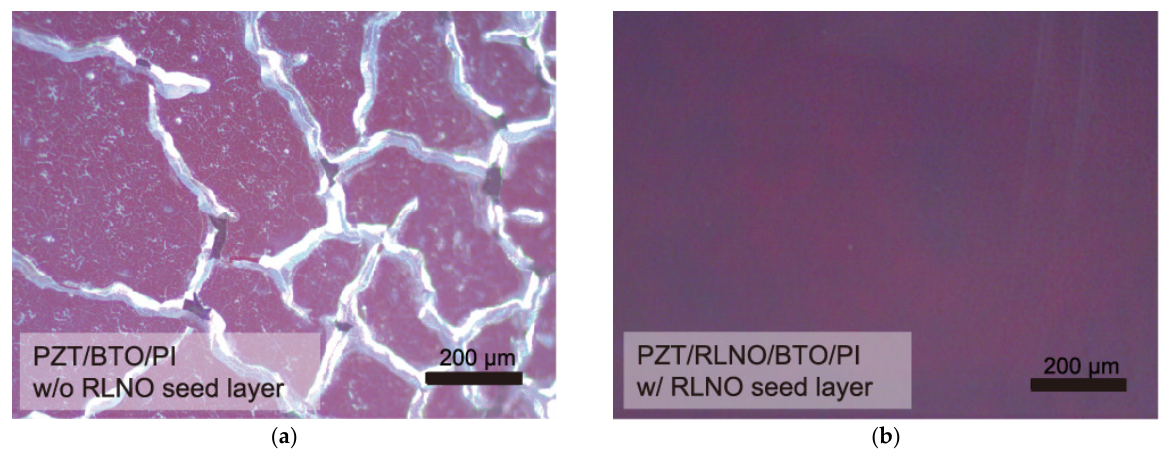
Figure 7. Optical microscope images for the PZT films prepared by the PCSD process at 50 mJ·cm − 2 ( a ) without and ( b ) (010)-oriented RLNO seed layers.